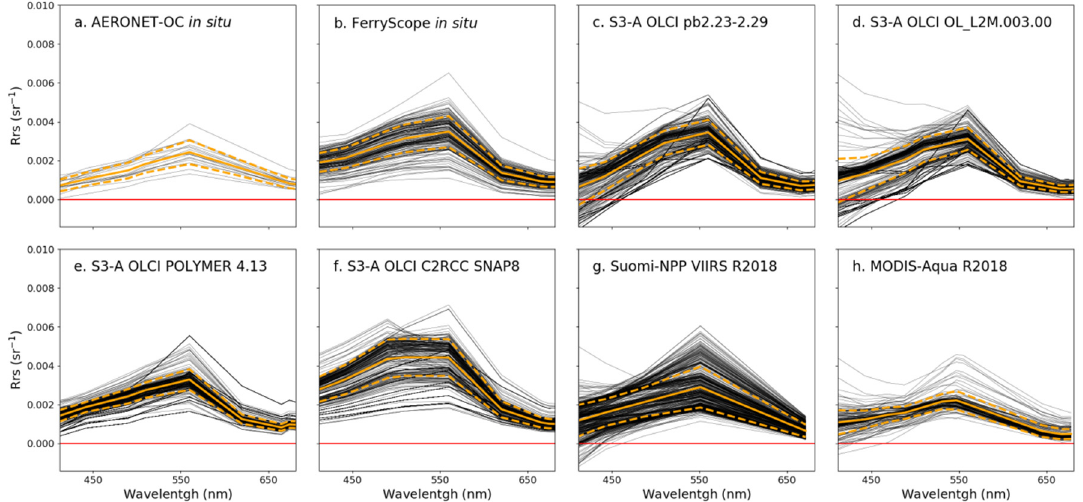
Figure 3. Remote sensing reflectance spectra, R rs ( λ ), for ( a ) in situ AERONET-OC; ( b ) in situ Alg@line; ( c ) OLCI-A processing baseline 2.23–2.29; ( d ) OLCI-A processing baseline OL_L2M.003.00; ( e ) OLCI-A POLYMER v4.13; ( f ) OLCI-A C2R-CC vSnap8; ( g ) Suomi-VIIRS R2018; ( h ) MODIS-Aqua R2018. Satellite R rs ( λ ) were within ± 1 h of in situ R rs ( λ ). The orange solid line is the mean and the dashed lines are ± 1 standard deviation for each data set.